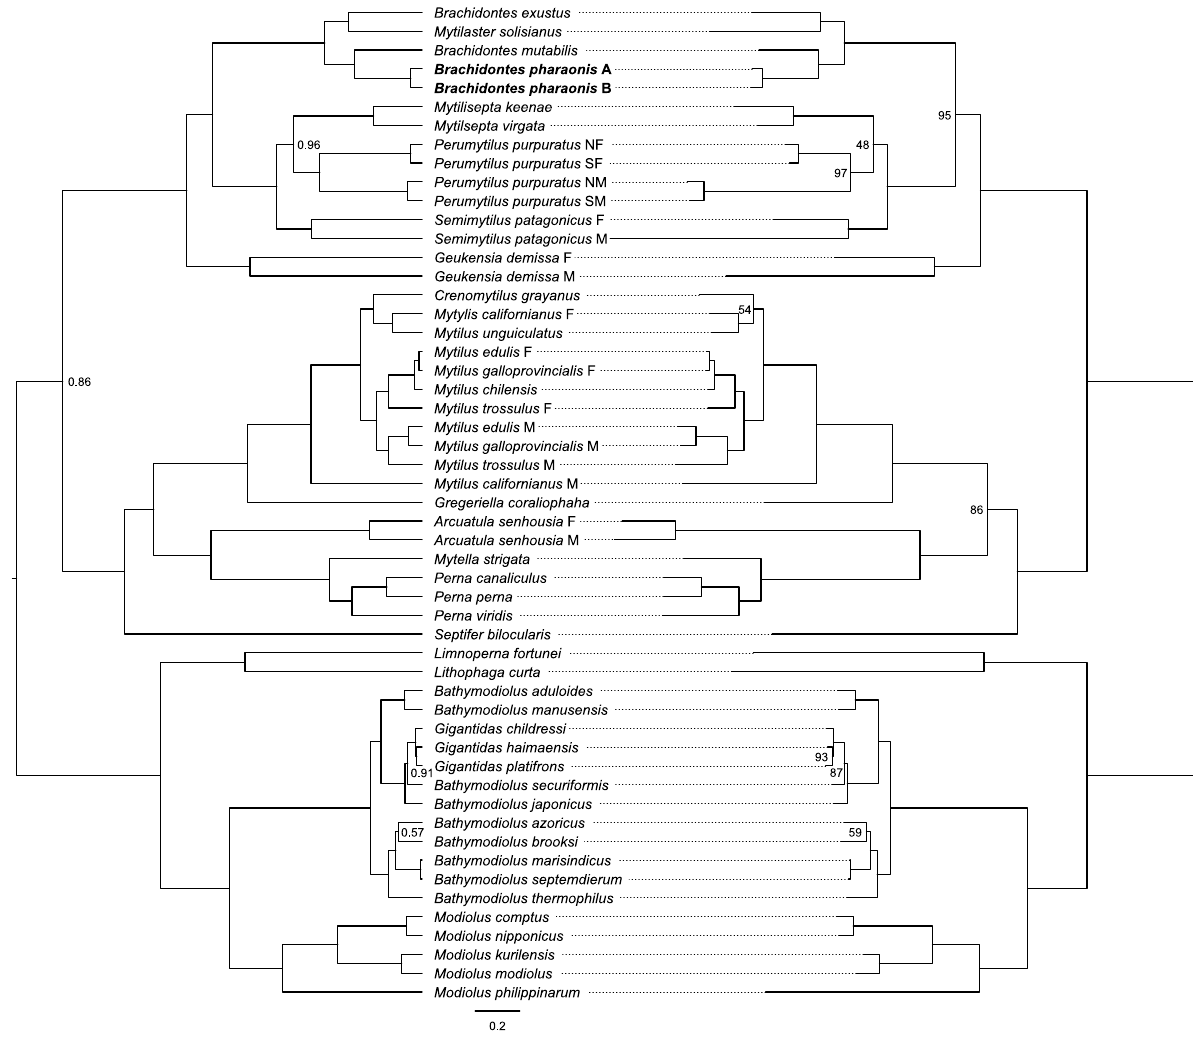
Figure 3. The phylogenetic position of Brachidontes pharaonis mitogenomes among mitogenomes of other mytilid mussels. The left tree represents Bayesian phylogenetic analysis done in BEAST2, and the right tree represents maximum likelihood analysis done in IQ-TREE. The nodes support values equaled 1 (Posterior probabilities, left) and 100% (bootstrap values, right), unless indicated (Table 2): each of them has some gender-specific structural features, but this is not the case for B. pharaonis. Here, both mitogenomes are structurally identical. Another feature of mtDNA, which has been reported in the context of DUI, is mitochondrial recombination 65,66 . The existence of very large repetitive elements suggests, that at least intramolecular recom- bination would be present in B. pharaonis . Yet, we have not found any evidence for the exchange of large parts between A and B mitogenomes. They apparently maintain their integrity, despite the conditions, which should favor the exchange 67 . The qPCR method would not detect low frequency, short span recombination so this has to be considered cautiously. However, no detectable signature of recombination is present within the A and B mitogenomic sequences, therefore even if such recombination is present, it is limited to somatic cells. Several studies postulated the existence of cryptic species within the Brachidontes genus ( B. pharaonis/vari- abilis 3 and B. puniceus/exustus 24,68 ). These were usually argued by the distinct divergence (p-distance) at the nucleotide level (~ 7–20%) between mitochondrial sequences. However, at the protein level, these distances were much lower (p-distance ~ 0–1.5%). These must be interpreted cautiously because only short fragments of